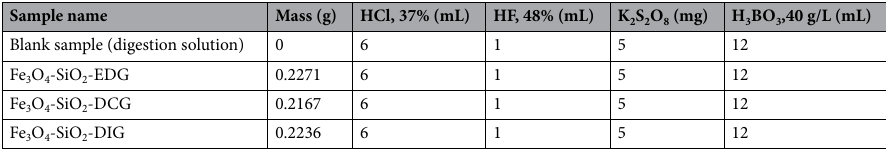
Table 1. Digestion protocol. *The digestion mixture was diluted: 1 mL mixture with 49 mL of ultrapure water.